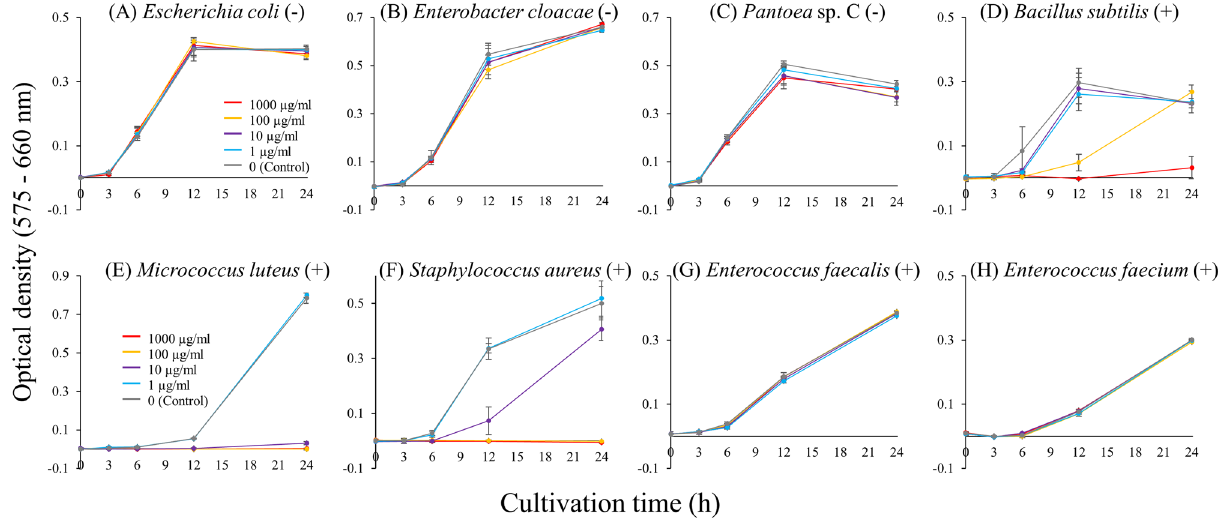
Figure 2. Analysis of the activity of Pentatomicin against eight bacterial species. ( A ) Escherichia coli . ( B ) Enterobacter cloacae . ( C ) Pantoea sp. C, the gut symbiont of P. stali . ( D ) Bacillus subtilis . ( E ) Micrococcus luteus . ( F ) Staphylococcus aureus . ( G ) Enterococcus faecalis . ( H ) Enterococcus faecium . Each bacterial culture was mixed with the recombinant Pentatomicin and incubated at 25 °C for 24 h. Bacterial growth was measured for 200 µl of culture medium at the wavelength of 575–660 nm. Values represent the means ± SD of three